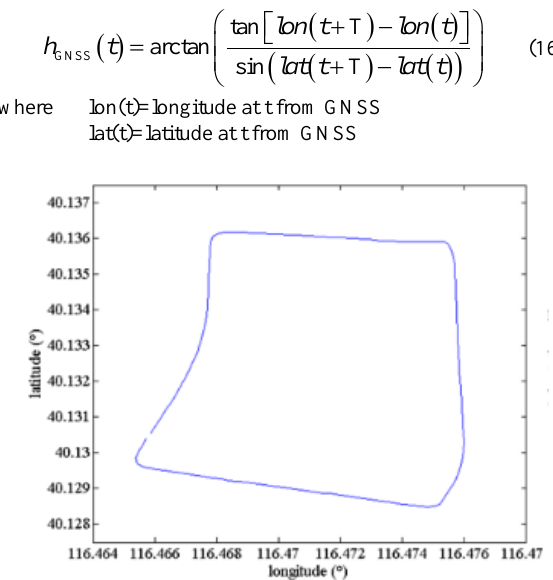
Figure 10. Route of the vehicle in the